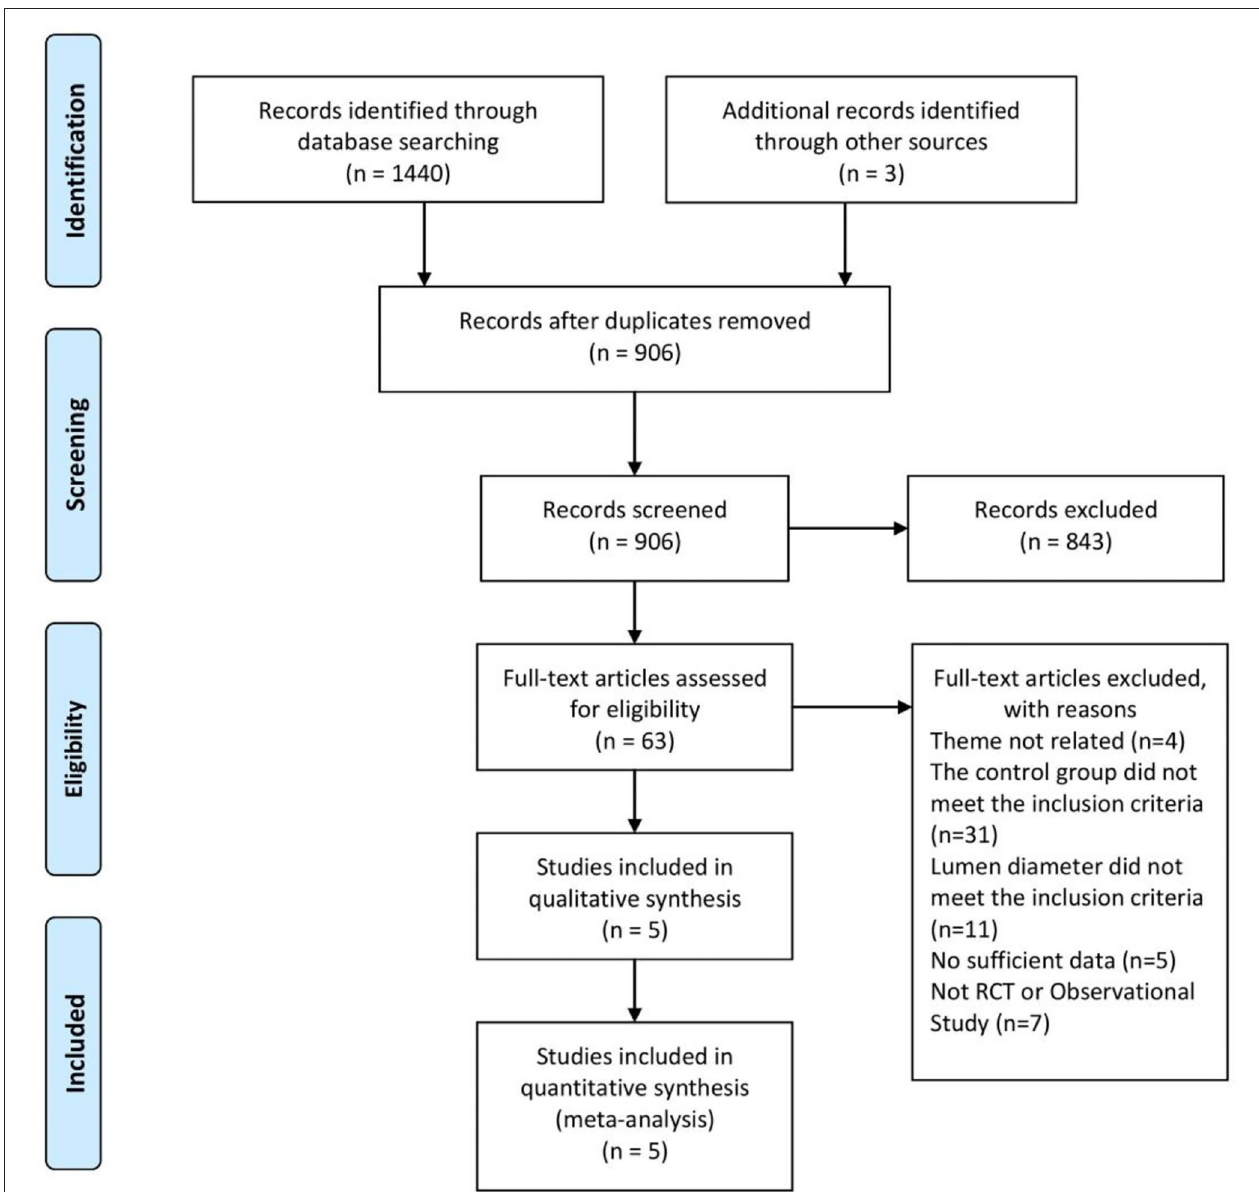
FIGURE 1 | Study selection